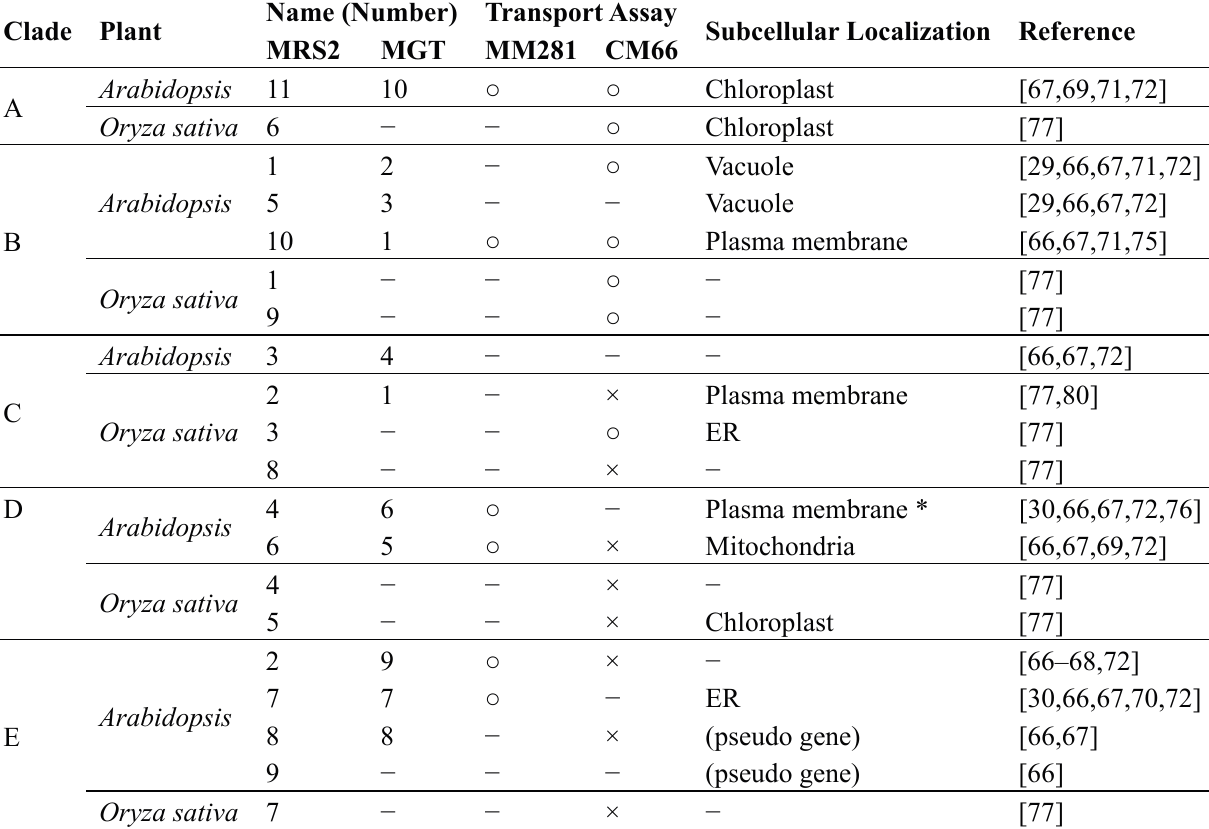
Table 1. 2-TM-GxN type Mg 2+ transporters in Arabidopsis and